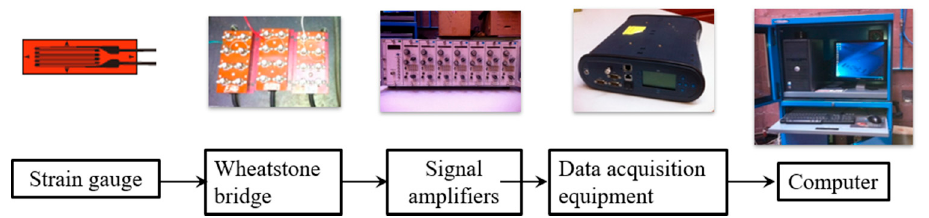
Figure 4 . Representation of the measurement chain used for each strain gauge .